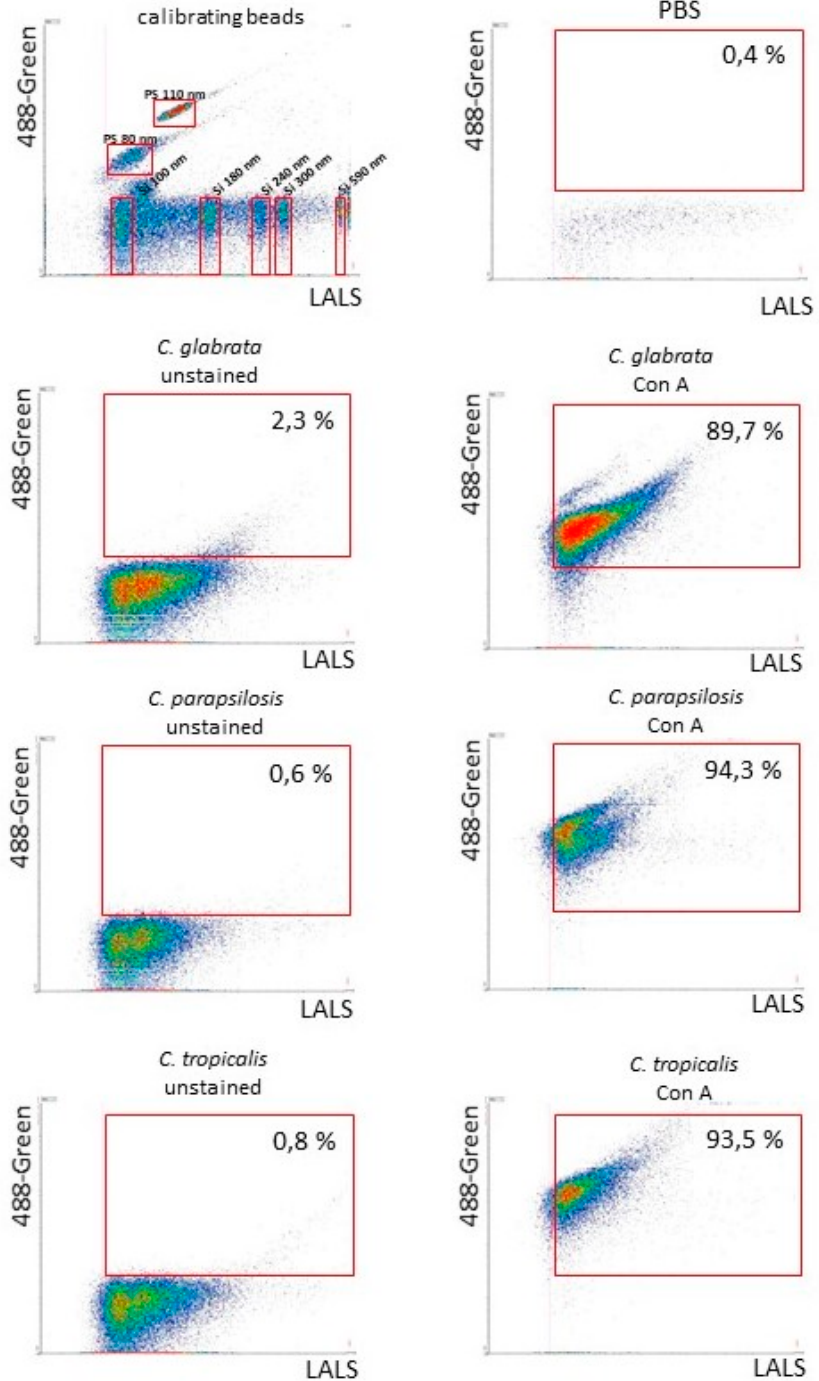
Figure 5. High-resolution flow cytometric detection of EV surface mannoproteins from C. glabrata , C. parapsilosis and C. tropicalis . Samples were analyzed with an Apogee A60-Micro-PLUS flow cytometer dedicated tothe analysisof smallparticles. The dotplot forcalibrating beads#1493 and#1517, containing a mixture of green-fluorescent polystyrene (PS) and non-fluorescent silica (Si) beads, is included as a size distribution reference. Representative dot plots of fungal EVs unstained and stained with concanavalin A (Con A) conjugated with fluorescein are presented. The percentage of objects positive for Con A binding is shown in selected regions marked with red frames. LALS, large angle light scatter parameter, proportional to the size of acquired